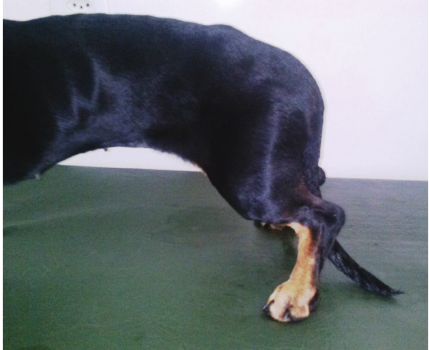
Figure 4: First minute weight bearing of dog (dog 2) 100 days after surgery.